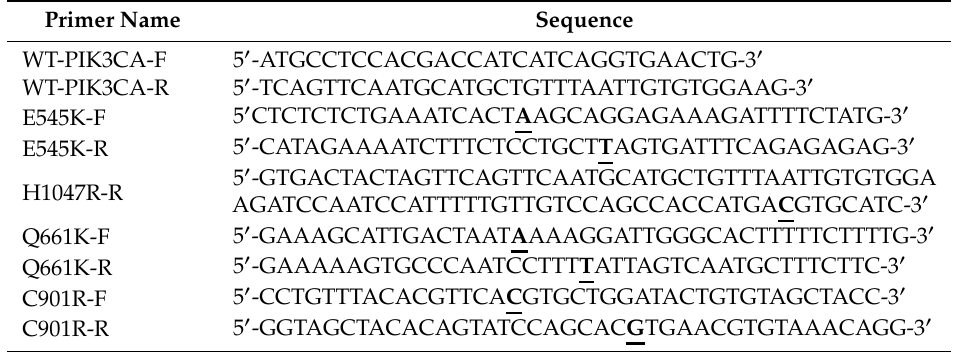
Table 1. Primers used for generation of phosphatidylinositol 3-kinase, catalytic subunit alpha (PIK3CA) wild type and mutant